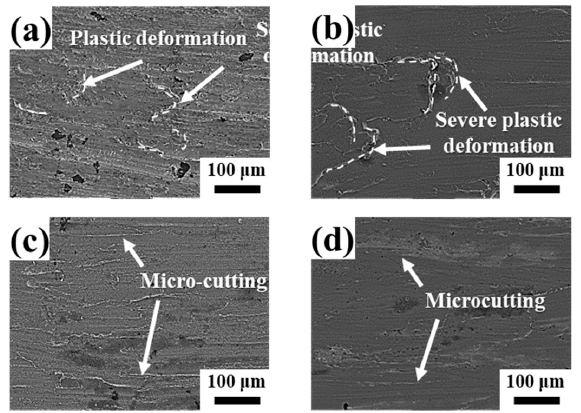
Figure 4. SEM micrographs of wear tracks on SUS316 blocks at rotation speeds of ( a ) 100 rpm and ( b ) 300 rpm, obtained from wear tests under dry conditions, and rotation speeds of ( c ) 100 rpm and ( d ) 300 rpm, obtained from wear tests under wet conditions.